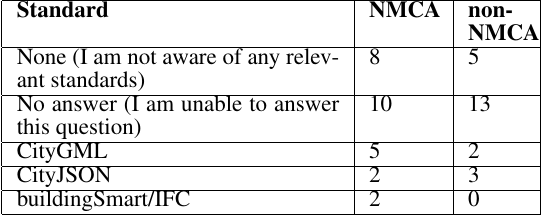
Table 1: Standards relevant to Digital Twins (note that some participants mentioned more than one